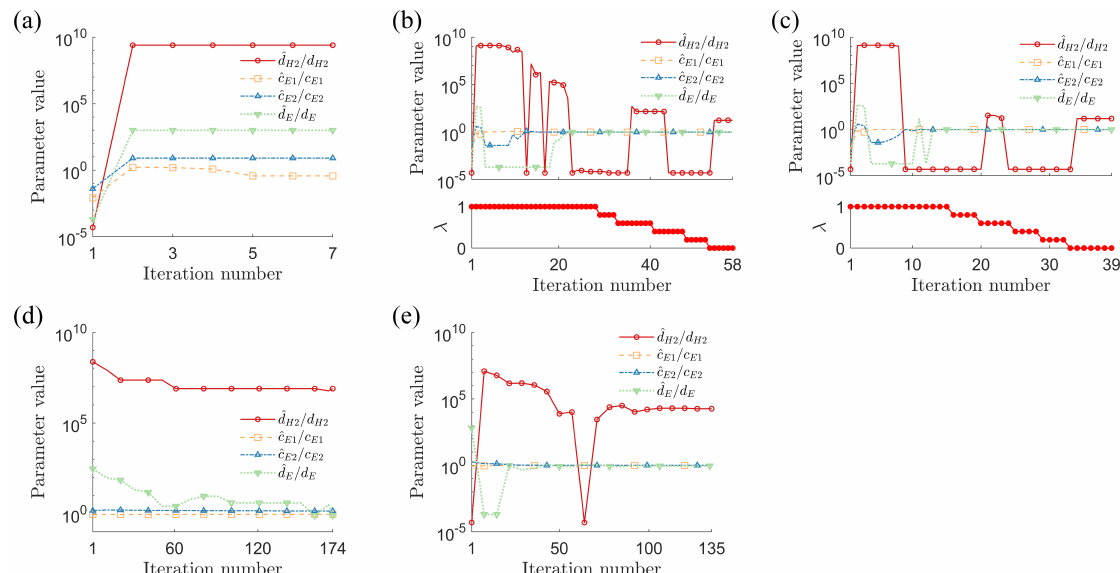
Figure 6. Evolution of parameter estimates (normalized relative to experimental values) for hydraulic engine mount system using five parameter identification strategies: ( a ) no controller, ( b ) proportional–derivative controller, ( c ) proportional–integral–derivative controller, ( d ) genetic algorithm, and ( e ) particle swarm optimization.